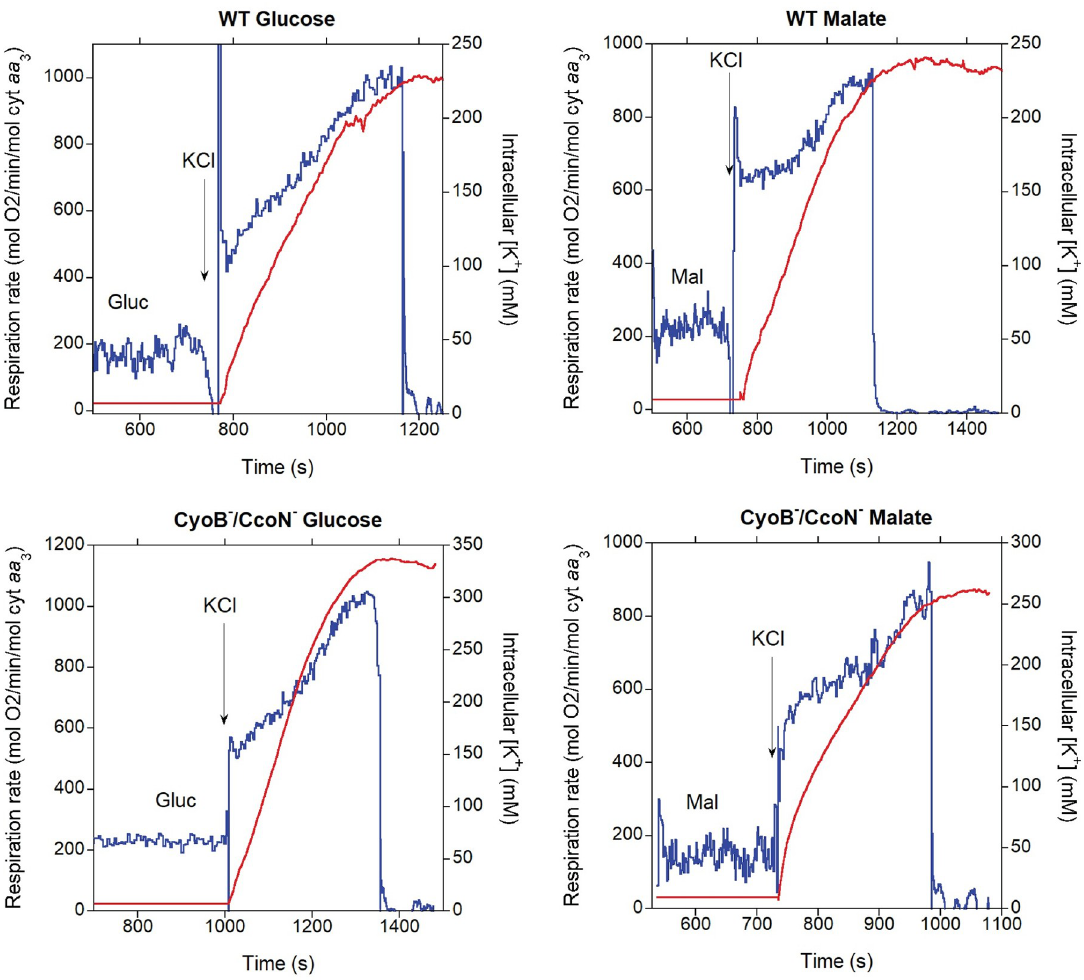
Fig 2. Respiration rate (blue) and intracellular [K + ] (red) before and after addition of 5 mM KCl. Thawed cells (~2 x 10 9 /ml) of the indicated strains were incubated in depletion NH 4+ -free buffer to which 11.1 mM glucose (Gluc; left panel) or 16.5 mM sodium malate (Mal; right panel) was added at ~500 s followed by 5 mM KCl at the time point indicated by the arrow in each